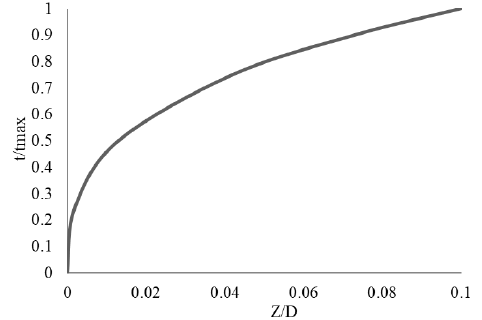
Figure 4. Typical tip load transfer–displacement (Q–Z) curve.